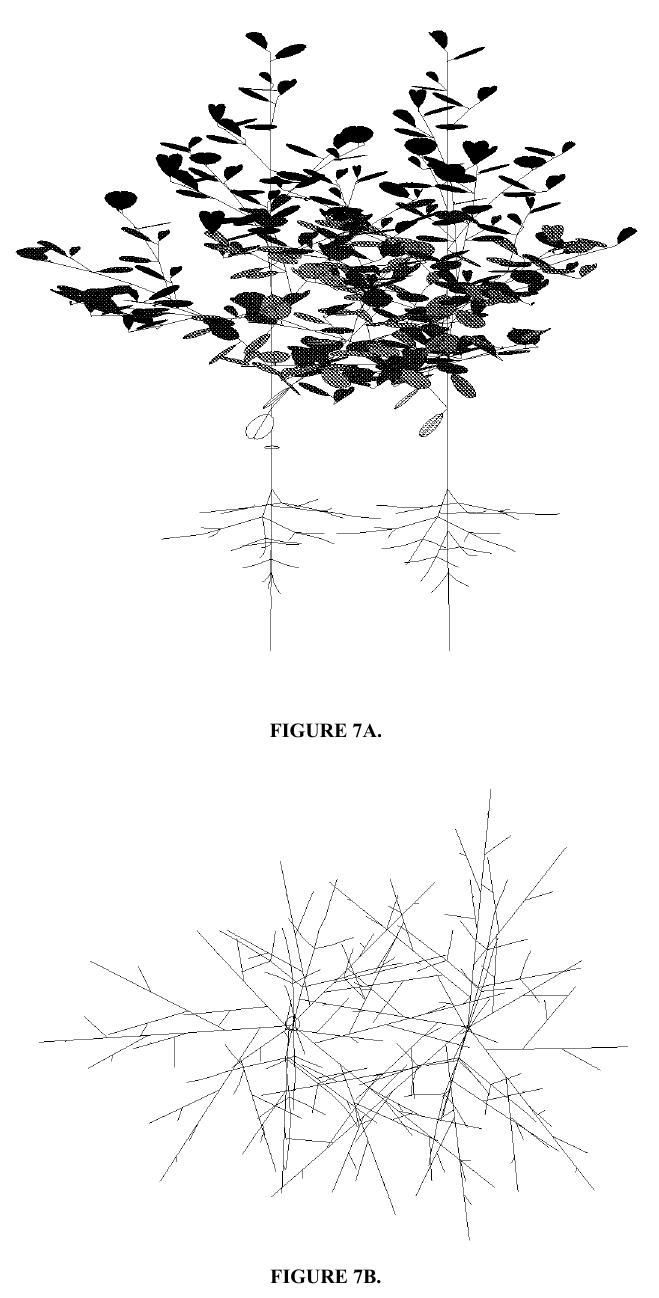
FIGURE 7. Graphical representation of a model run that simulates competition for light of two young alder trees. Different light exposure of leaves due to mutual shading leads to different amounts of assimilant gain (indicated by grey shading of leaves). As a result of these differences local structural adaptations of the plant architecture occur due to different local growth rates. A horizontal view and a vertical view of the shoot (without leaves) are